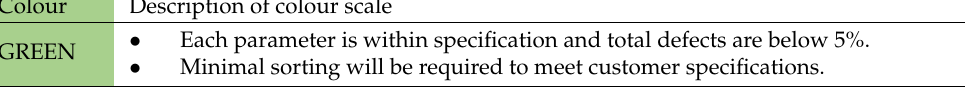
Table 6. The four colour categories used to grade the final QC outcome of a pallet. Colour Description of colour scale